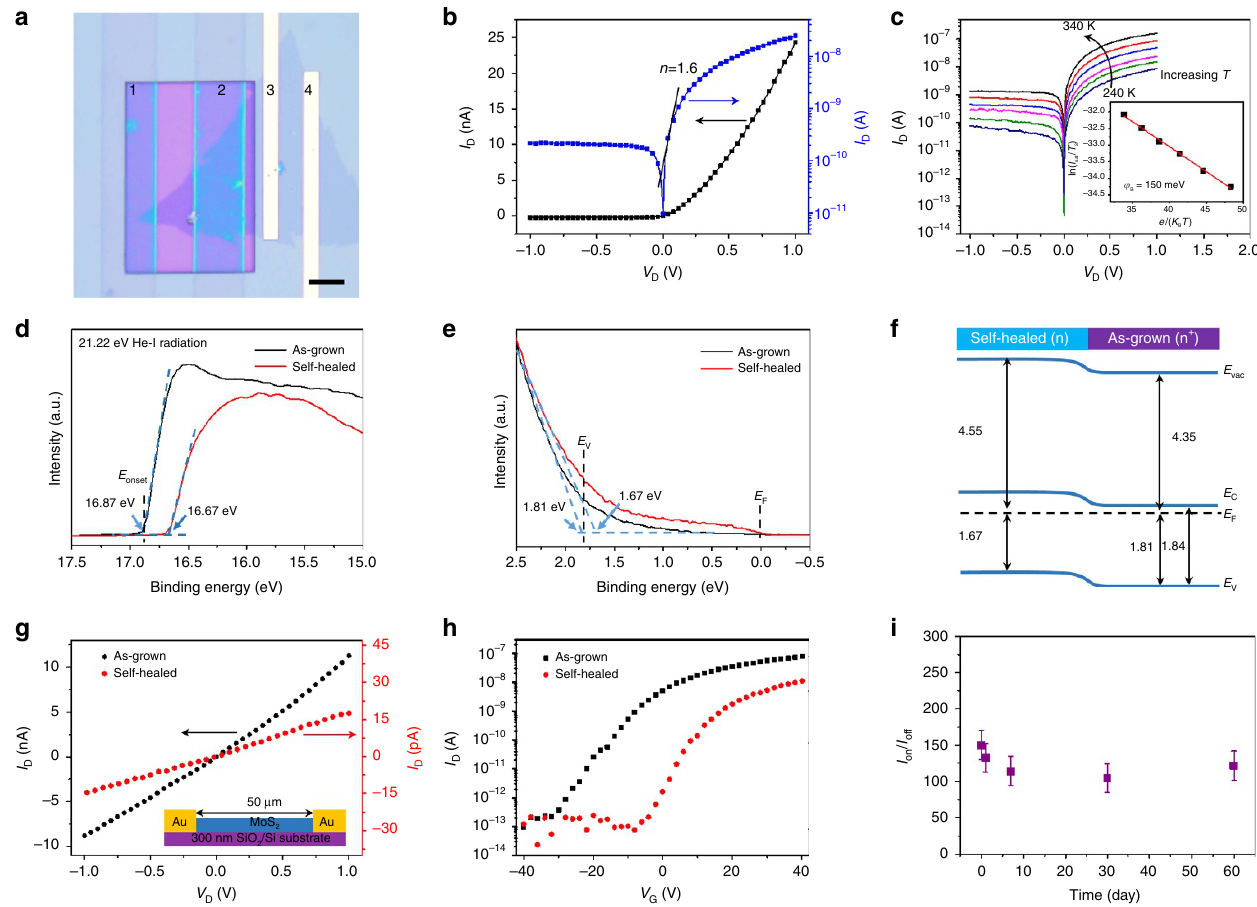
Figure 3 | Construction and electrical properties of MoS 2 homojunction. ( a ) OM image of the device A 2 . PEDOT:PSS electrodes 1–2 define an self-healed MoS 2 FET, 3–4 define an as-grown MoS 2 FET, and 2–3 define the homojunction device A 2 . Scale bar, 5 m m. ( b ) Output characteristic on linear/logarithmic scale (black/blue) of the device A 2 . ( c ) Output characteristic of the homojunction under a series of temperatures. Inset: linear fitting result of the relationship between ln( I DS /T 3/2 ) and e/(k B T ). The red line fit is drawn to yield the Schottky barrier height. ( d , e ) Secondary-edge and valence-band spectrum of the ultraviolet photoelectron spectroscopy (UPS) measurement from as-grown and self-healed monolayer MoS 2 . ( f ) Band diagram of the monolayer MoS 2 homojunction obtained from UPS measurements. ( g , h ) Output characteristics and transfer characteristics of a monolayer MoS 2 transistor both before and after PSS-induced SVSH. ( i ) I on / I off ratio of the homojunction measured during 60 days of storage under ambient